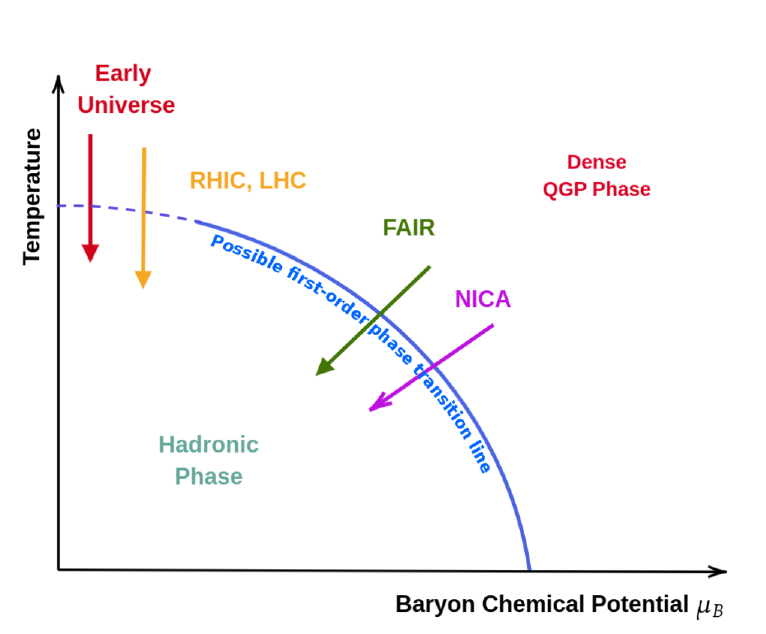
Figure 1 . QCD phase diagram. The yellow line indicates the region that can be accessed by RHIC and LHC experiments. The green and purple lines show the region accessed by FAIR and NICA, respectively. In red, we indicate the two regions discussed in this introduction. The early universe in the µ B = 0 axis, and the dense QGP region, where lies the interest of this